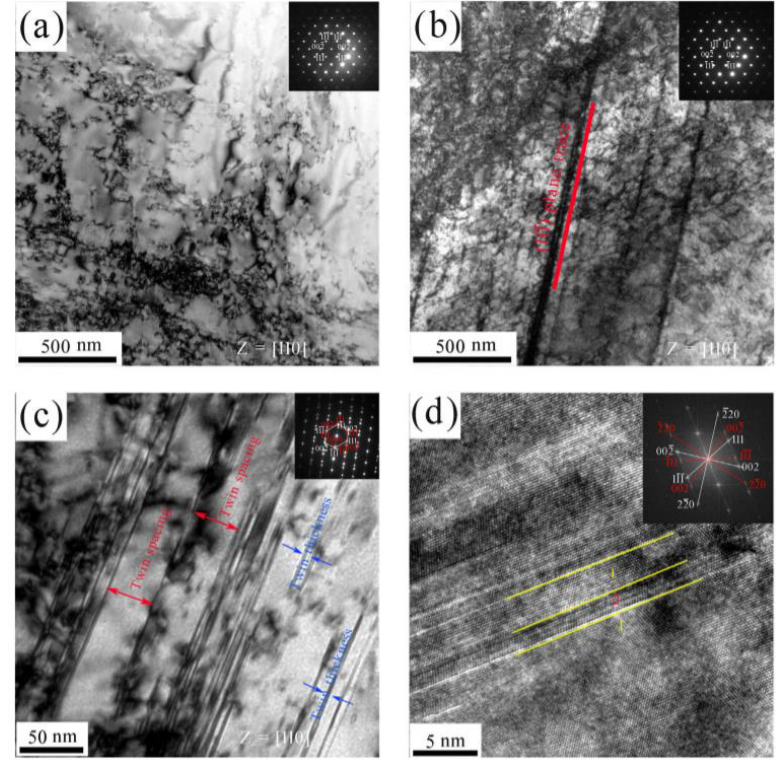
Figure 22. TEM bright field images of the Al 0.1 CoCrFeNi alloy tested at ( a ) 25 ◦ C (298 K), which indicates that there is a tendency toward the dislocation-cell formation when the strain reaches 50%, ( b ) − 73 ◦ C (200 K), with the (111)-type slip plane, ( c ) − 196 ◦ C (77 K), which displays nanotwins, and ( d ) the corresponding high-resolution TEM image for ( c ) that displays the region where two deformation twins with a thickness of about 2 nm are located. The selected area electron diffraction patterns and fast Fourier transform (zone axis (110)) are also displayed (reproduced from Reference [285] with